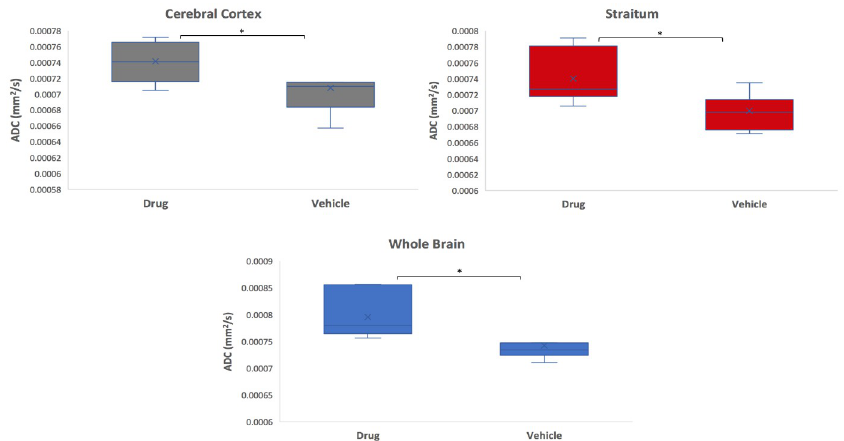
Fig 5. Boxplots of apparent diffusion coefficient in the cerebral cortex (grey), the striatum (red), and whole brain (blue). In each figure, left: TGN-073-treated group; right: vehicle group. Asterisks indicate significant differences: � P <